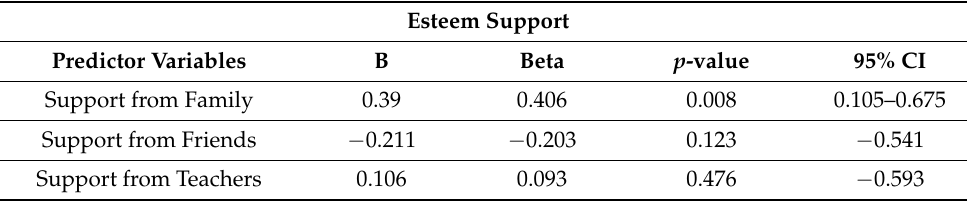
Table 5. Results of multiple linear regression analysis to determine the relationship of support from family, friends, teachers, and colleagues with esteem support and social integration